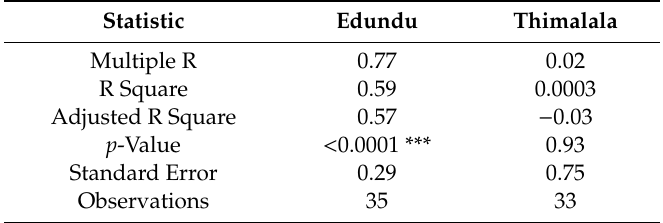
Figure 5. Comparison of farmers’ estimates of farmlands with results of PPGIS mapping. Table 2. Regression statistics of the relationship between farmers’ estimates and GNSS measurements of the two